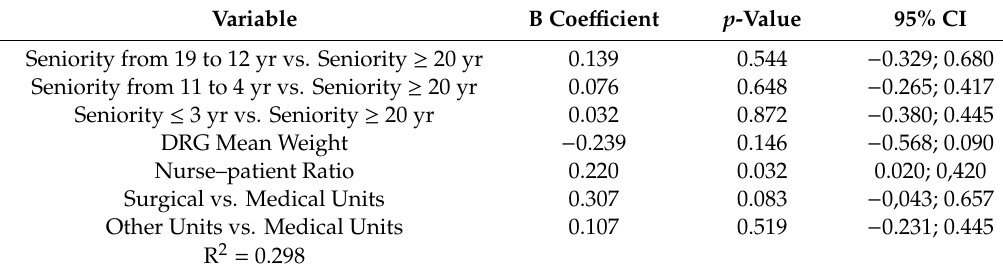
Table 4. Percentage of cases with the assessment